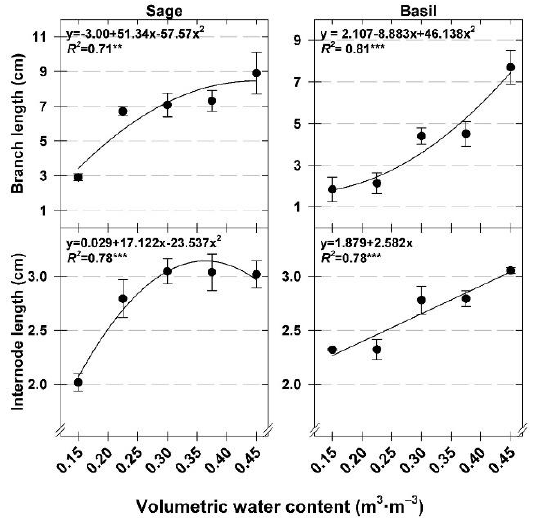
Figure 5. Branch and internode length of sage (Expt. 1) and basil (Expt. 2) grown in 11.4 cm diameter containers filled with a soilless substrate comprising (by vol.) 75% sphagnum peat moss and 25% coarse perlite amended with 3.0 kg · m − 3 controlled-release fertilizer and maintained at 0.15, 0.23, 0.30, 0.38, or 0.45 m 3 · m − 3 substrate volumetric water content for four weeks. Regression lines are presented for significant correlations only with corresponding R 2 presented. ** or *** indicates significant at p ≤ 0.01 or 0.001, respectively.